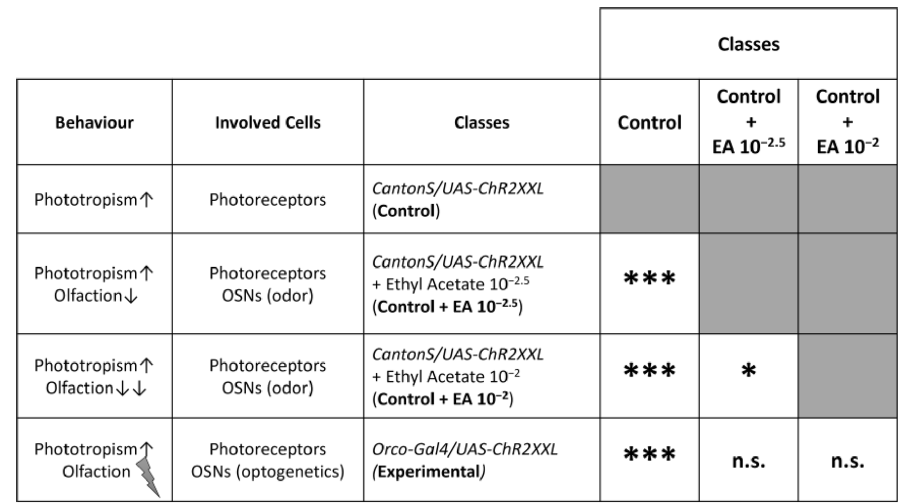
Figure 5. Phototropism vs. Olfactory Response. ( A ) Response to light of experimental individuals (Orco-Gal4/UAS-Chr2XXL) with optogenetic activation of Orco-expressing Olfactory Sensory Neu- rons (OSNs) compared with control individuals (CantonS/UAS-ChR2XXL) responding to light or a combination of light and odor (Ethyl Acetate 10 − 2.5 and 10 − 2 ). Bars represent Mean PI±SEM. ( B ) Table of significant differences. The behavior and cells involved in the response of each of the four classes compared are presented along the significant differences found among the classes. (* = p < 0.05; *** = p < 0.001; n.s. = not significant differences). The white squares represent all possible two-by-two comparisons. The gray squares correspond to nonsense or repeated